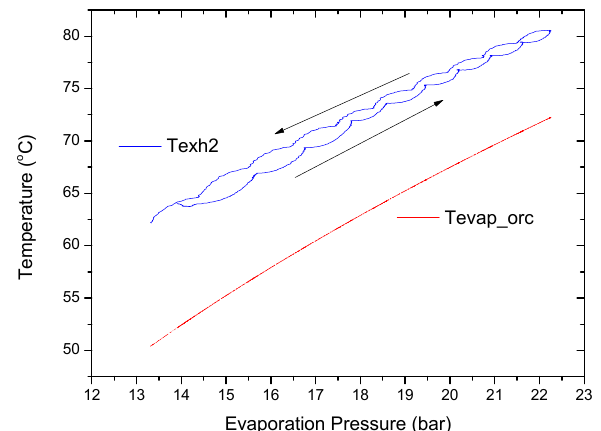
Figure 11. Exhaust outlet temperature with variation in evaporation pressure.